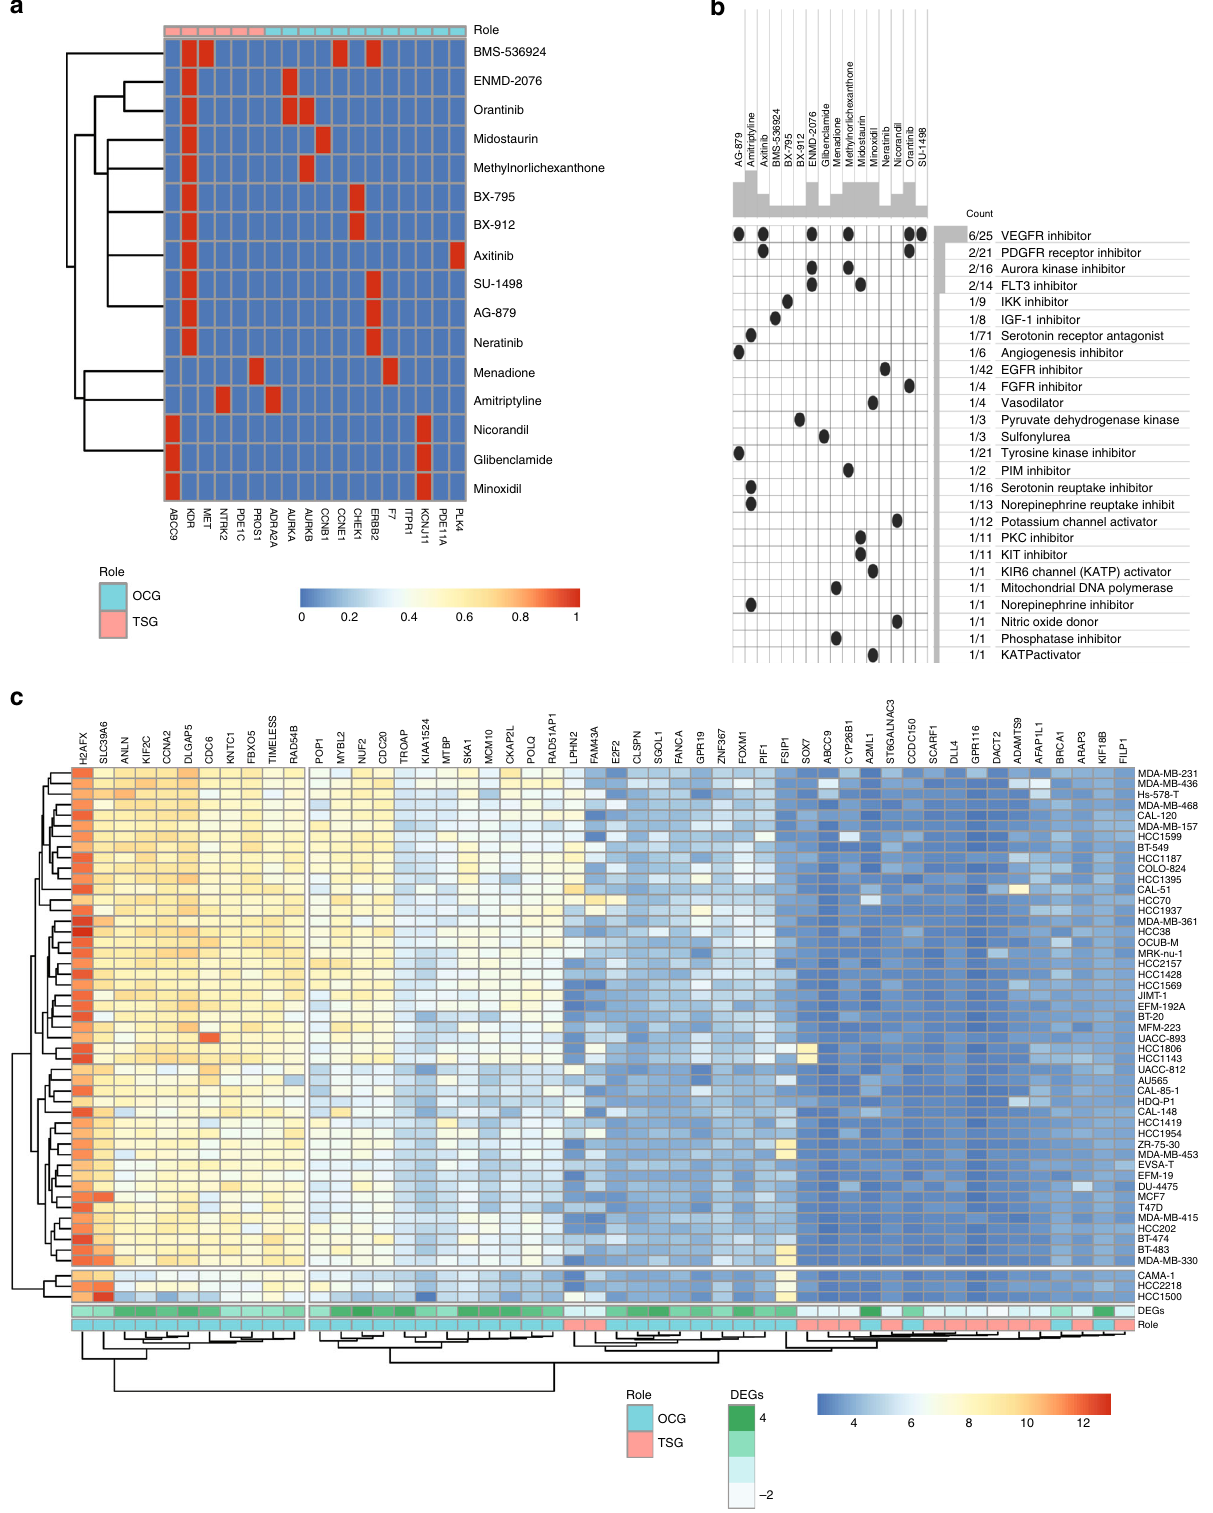
Fig. 7 Moonlight intratumor heterogeneity, cell line, and drug analysis. a Heatmap showing each compound (perturbagen) in rows from the Connectivity Map that share gene targets predicted as OCG (salmon) or TSG (teal) in columns. A red square indicates the presence of a relationship between compound and target. b Heatmap showing each compound (perturbagen) in columns from the Connectivity Map that shares mechanisms of action (rows), sorted by descending number of compounds with shared mechanisms of action. c Heatmap showing the top 50 TSG and OCG (by Moonlight Gene Z- score) predicted in breast cancer as mediators of apoptosis and proliferation (columns) and expression pro fi les of 50 breast-cancer cell lines from the Genomics of Drug Sensitivity in Cancer (GDSC) database